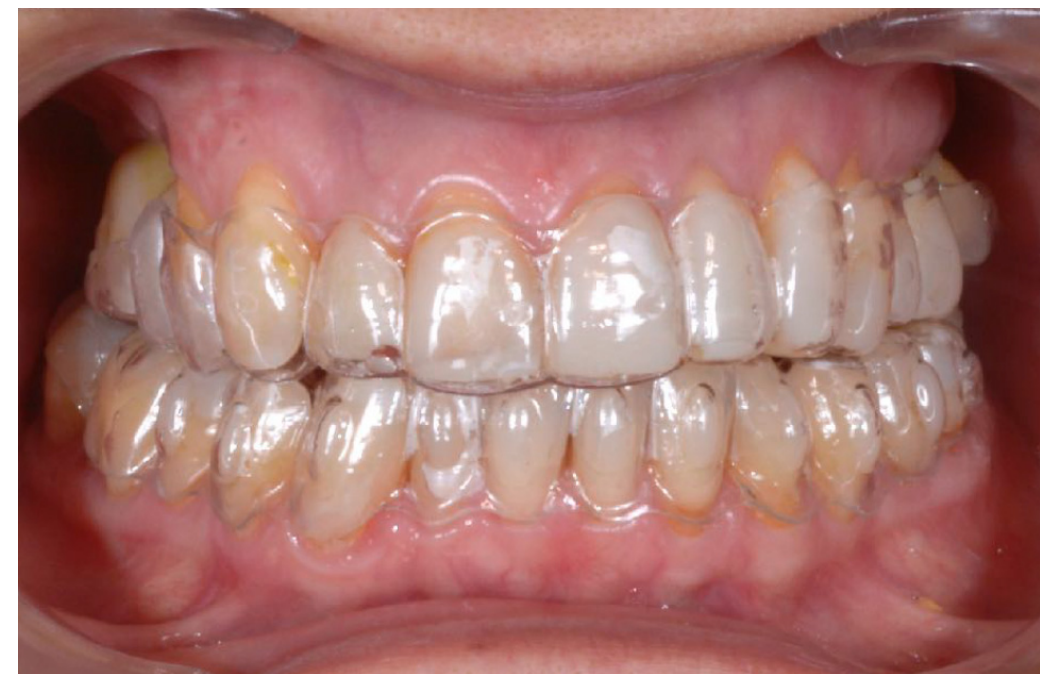
Figure 8. Orthodontic treatment with customized aligners based on the mock-up.